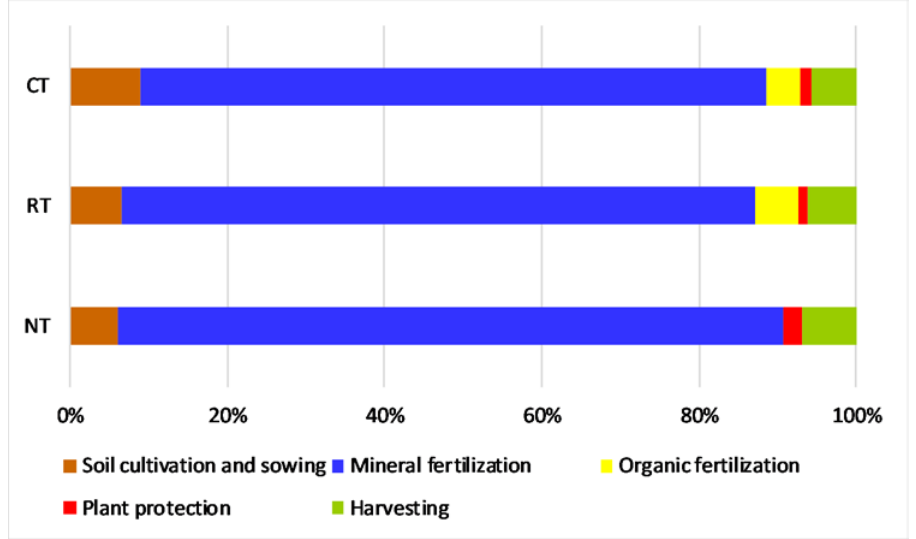
Figure 6. Contribution of field operations to the carbon footprint of the maize production in conventional tillage (CT), reduced tillage (RT) and no-tillage (NT).